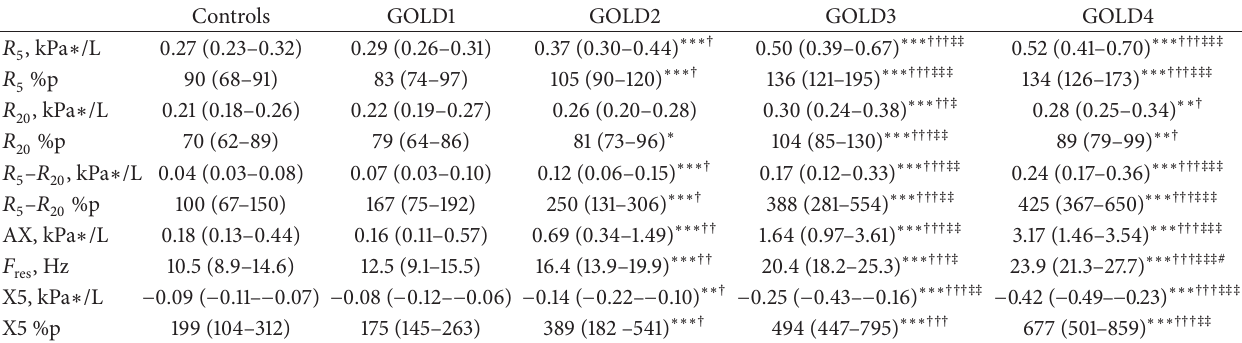
Table 3: Impulse oscillometry parameters.